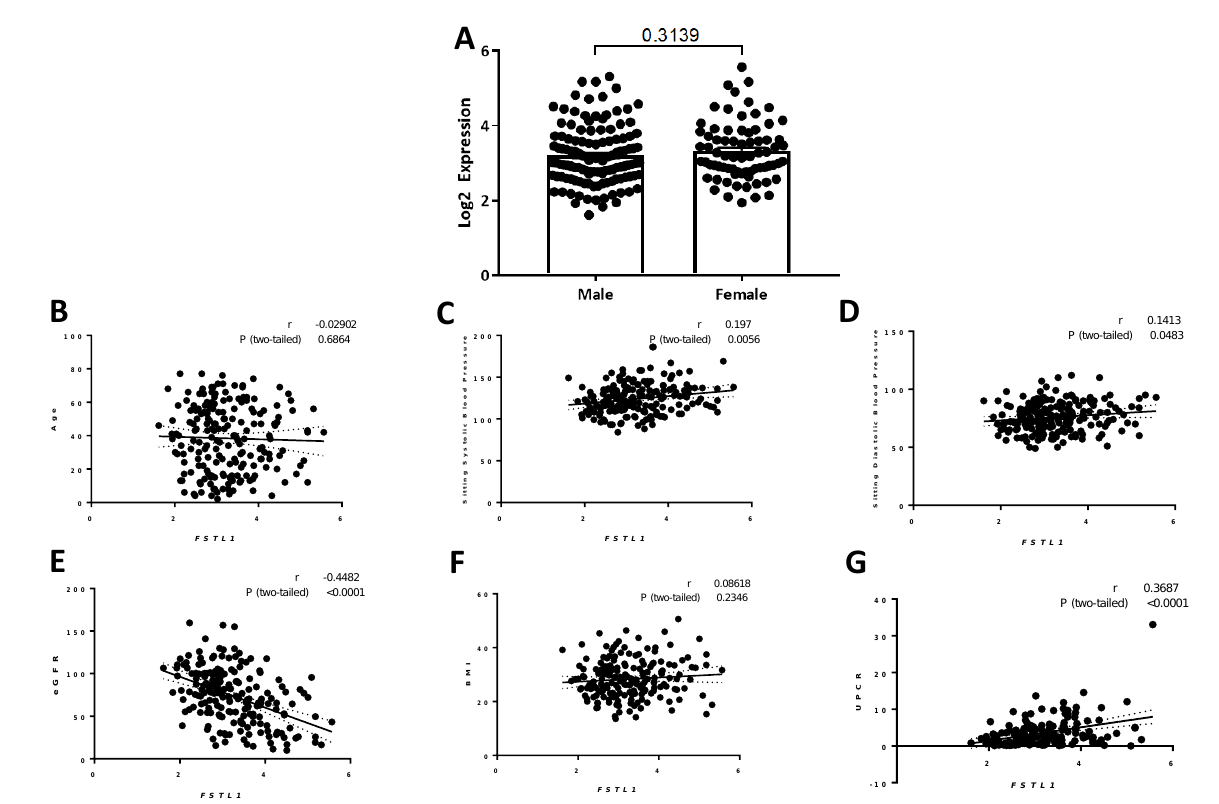
Figure 20. Relationship of tubulointerstitial FSTL1 expression to clinical variables in the cohort of FSGS, IgAN, and MN. ( A ) FSTL1 mRNA levels in male subjects compared to female subjects. ( B – G ) FSTL1 mRNA levels correlated against ( B ) age, ( C ) sitting systolic blood pressure, ( D ) sitting diastolic blood pressure, ( E ) estimated glomerular filtration rate (eGFR), ( F ) Urine Protein to Creatinine Ratio (UPCR), and ( G ) Body Mass Index (BMI). Pearson’s correlation coefficient ( r ) was determined, and two-tailed p values derived. Significance was determined as a p value of <0.05. Linear regression generated the line of best fit (solid lines) with 95% confidence intervals (dotted lines). Significance was determined as a p value of <0.05. Table 3. Multiple linear regression analysis of FSTL1 expression.